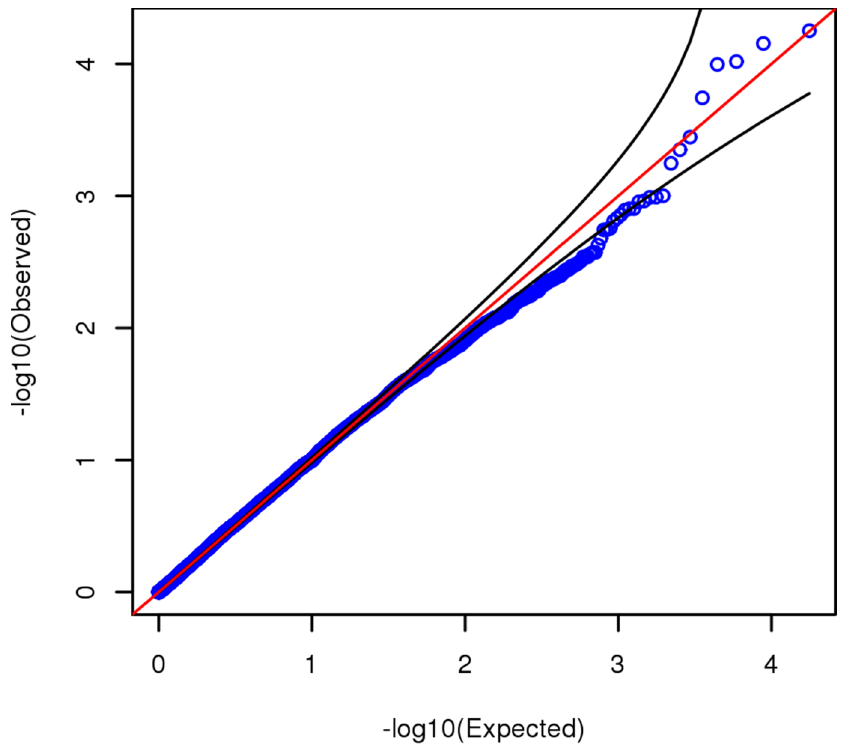
Figure 4. Uniform quantile-quantile plot for gene-based p -values from VEGAS . Analysis input was GWAS p -values from 2,485,149 autosomal SNPs, both observed and imputed. Black curves delineate 95% confidence